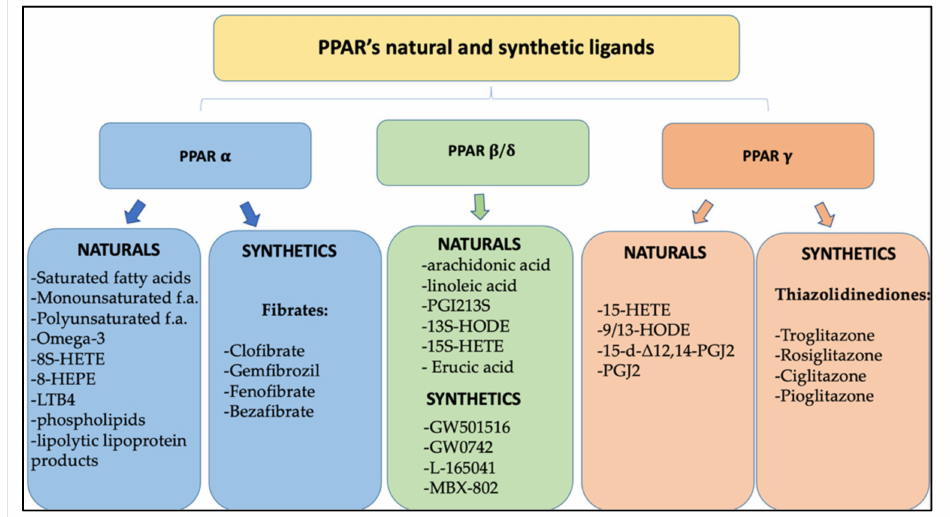
Figure 2. Classification of natural and synthetic ligands of PPARs